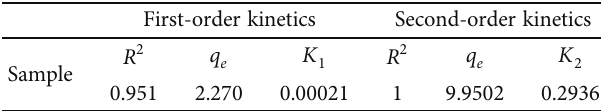
Table 8: Adsorption kinetics parameter results for chemically modi fi ed neem biomass bioadsorption